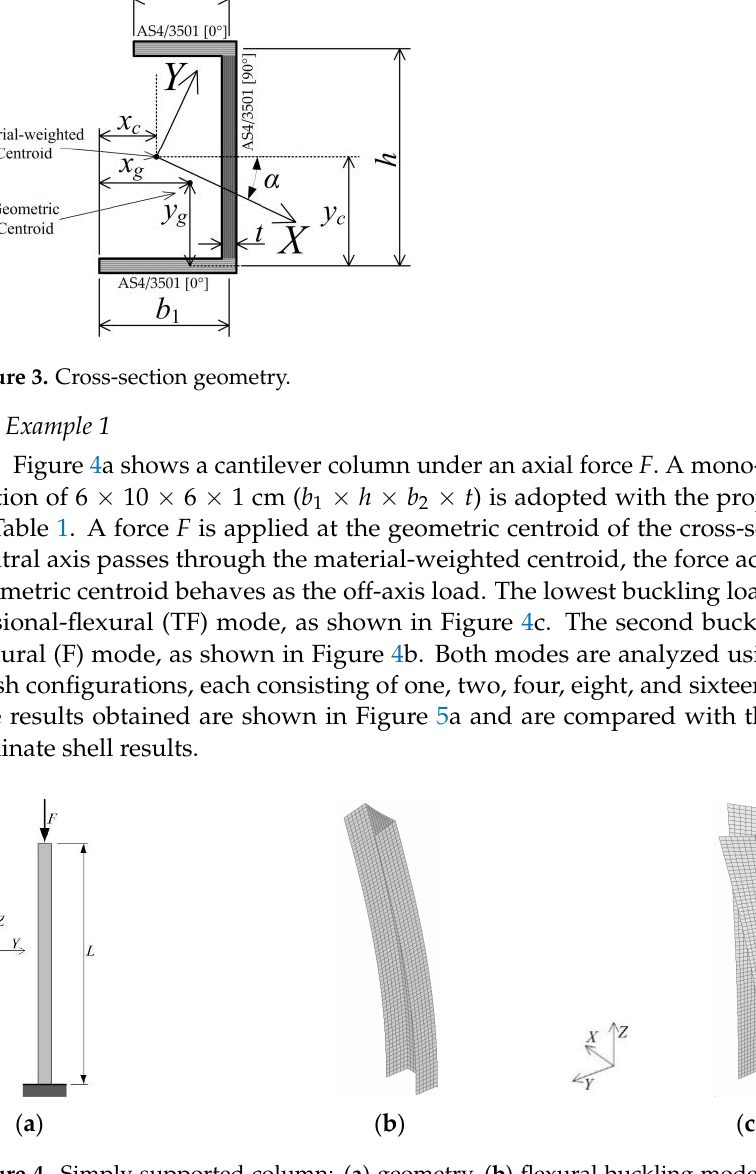
Figure 3. Cross-section geometry.